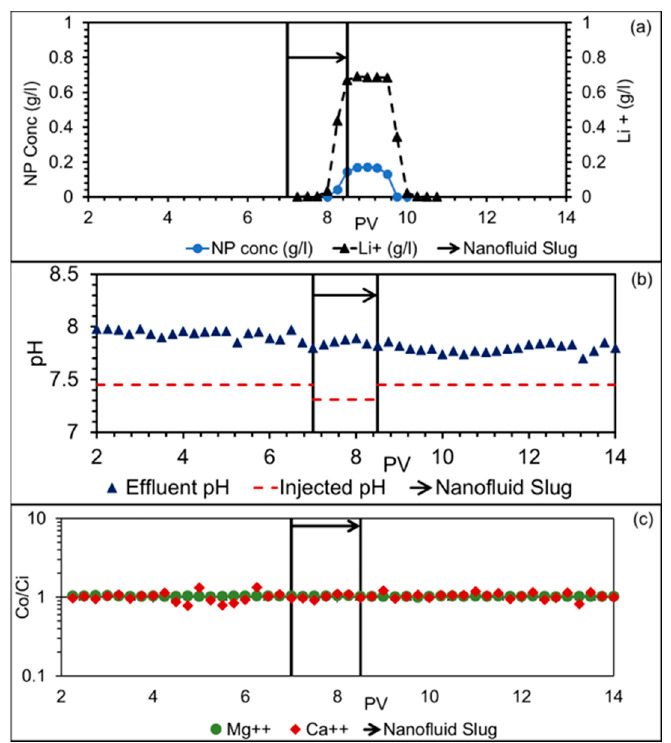
Figure 5. ( a ) NP and tracer concentration profile, ( b ) effluent pH profile and ( c ) effluent Ca 2+ and Mg 2+ concentration for SK3 in SSW.